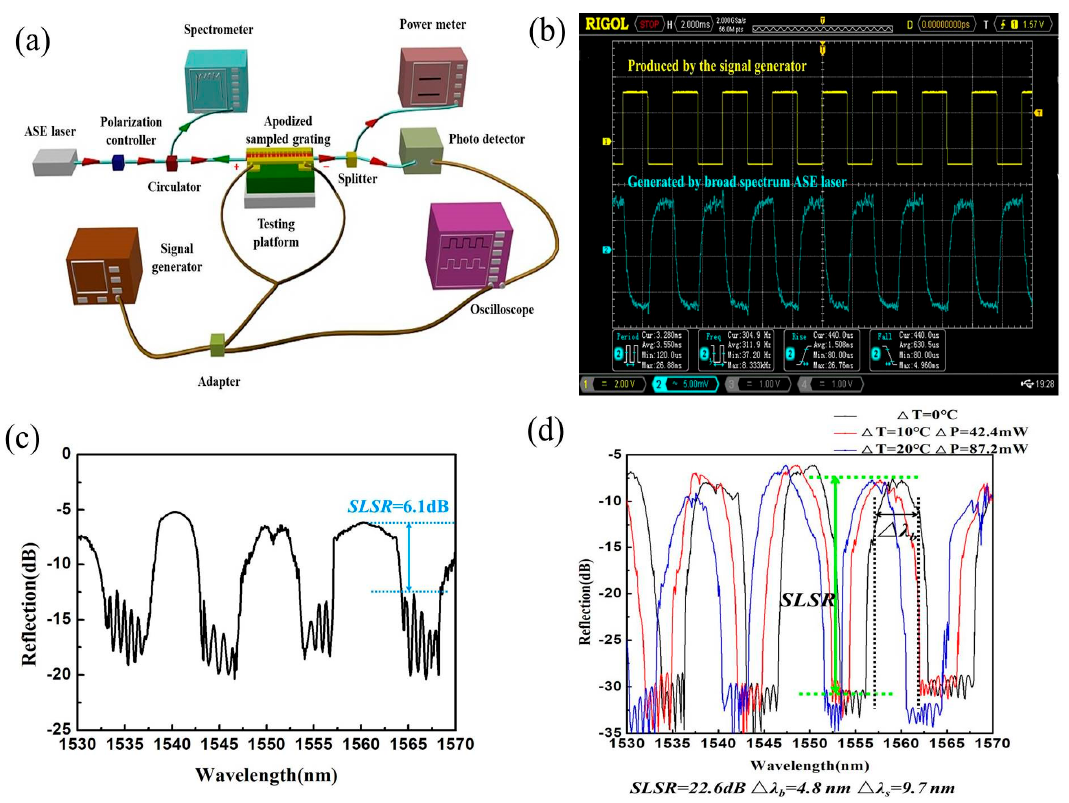
Figure 12. ( a ) Schematic diagrams of the measurement system; ( b ) TO switch responses obtained by applying a square-wave voltage at frequency of 300 Hz; ( c ) Reflection spectrum of traditional Bragg sampled grating; ( d ) Reflection spectrum of proposed Bragg sampled grating and its thermo optic tunable characteristic at Δ T = 0 °C, 10 °C, and 20 °C. Table 2. Comparison of other published results for Bragg waveguide gratings.